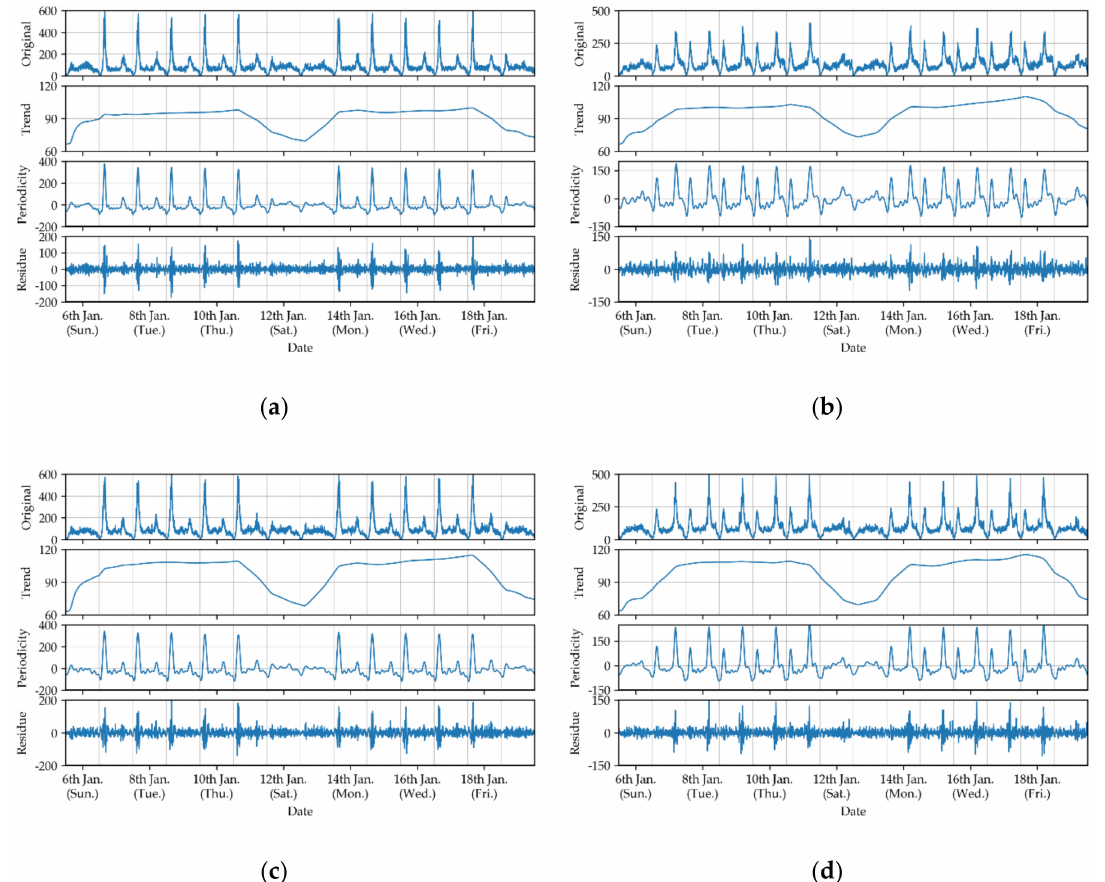
Figure 6. Decomposition results: ( a ) exit passenger flow of the Qianjiang Road Station, ( b ) entrance passenger flow of the Q.R. Sta., ( c ) exit passenger flow of the J. Sta., and ( d ) entrance passenger flow of the J.